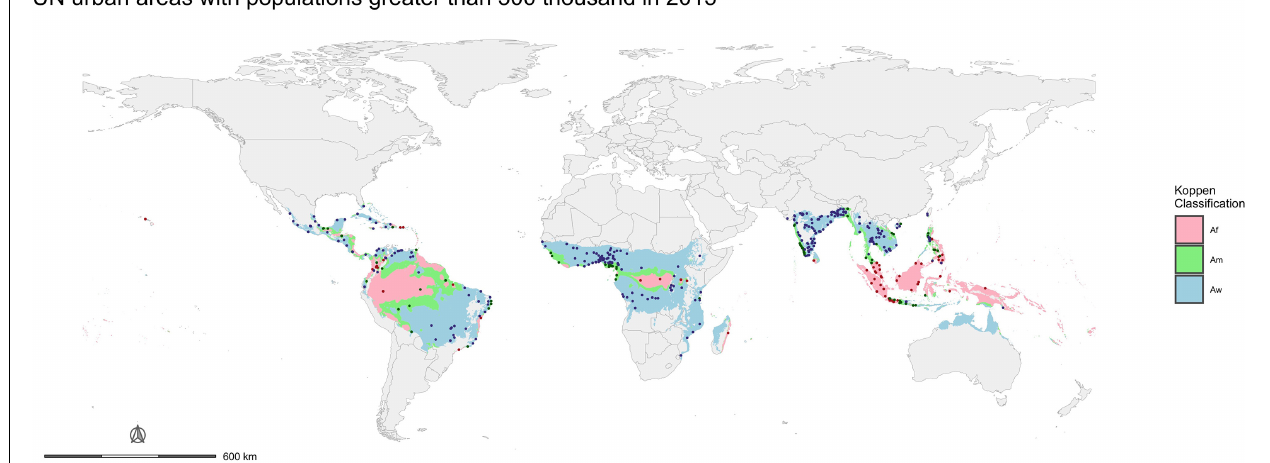
FIGURE 3 | Location of cities with more than 300,000 population in 2015 within tropical climates. The dots represent city locations and are color-coded by Köppen-Geiger classification. Data source: UN, 2018.